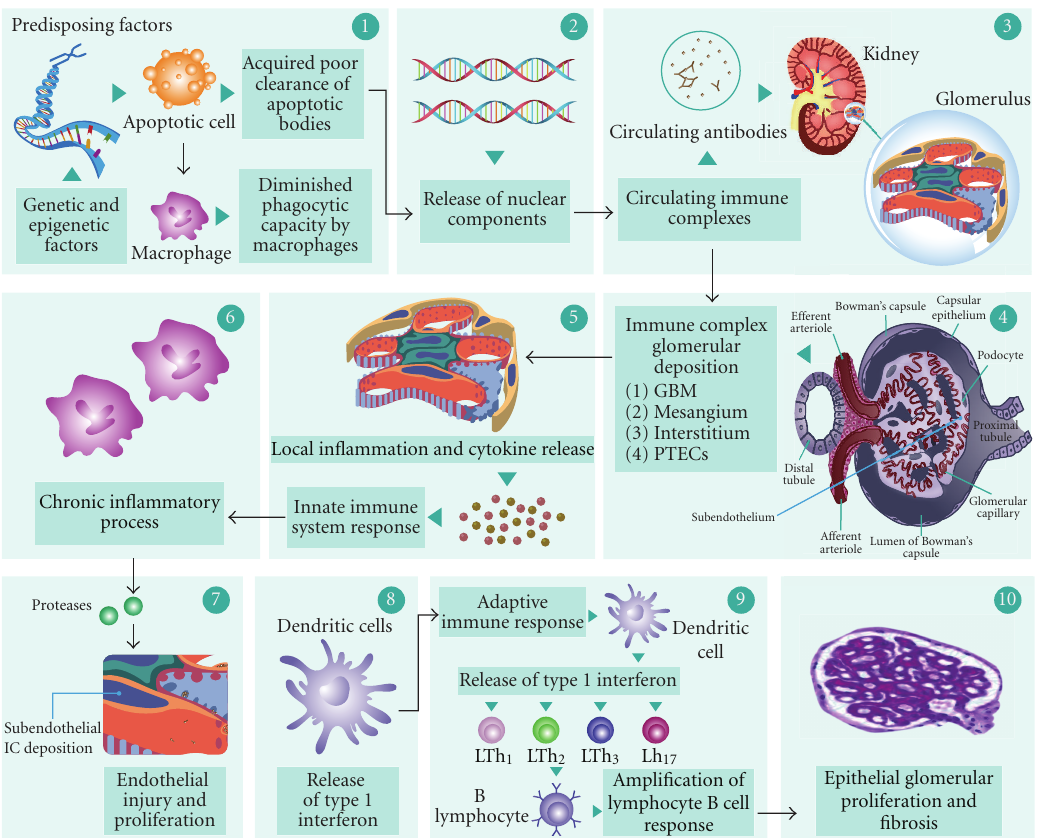
Figure 1: Lupus nephritis: an imbalance between cytokine homeostasis and immune complex deposition. In predisposing susceptible individuals who develop systemic lupus erythematosus (SLE), there is an acquired poor clearance of apoptotic bodies and a diminished phagocytic capacity by macrophages (1). Early formation of immune complexes (ICs) include antinucleosomes, anti-double-stranded DNA (anti-dsDNA), DNA extractable nuclear antigen antibodies (ENAS), antibodies against C1q complex of the complement system, free DNA, antiribonucleoproteins (anti-RNP), and histones as byproducts of ine ffi cient phagocytosis of apoptotic bodies (2). Circulating ICs are deposited initially at the glomerular base membrane (GBM), mesangium, and interstitial tissue within the proximal tubular epithelial cells (PTECs) (3) and (4). The deposited ICs initiate the release of proinflammatory cytokines and chemokines such as monocyte chemoattractant protein 1 (MCP-1), interleukins 1 and 6 (IL-1, IL-6) and adhesion molecules (CAMs) thus establishing a chronic inflammatory process (5). The resulting overload of the mesangial phagocytic system (innate immune system) leads to deposits of subendothelial ICs becoming an easy target for monocyte migration and infiltration and generating endothelial injury and proliferation (6) and (7). In turn, the adaptive immune system is activated secondary to the presence of ICs and dendritic cells (DCs) (8), which subsequently trigger release of type 1 interferon and induce maturation and activation of infiltrating T cells. This activation leads to sequential amplification of T helper 2 lymphocytes (Th2), T helper 1 (Th1), and T helper 17 (Th17) (9). Each of these amplifies lymphocyte B cell response and further activates macrophages, generating a second general response, which increases recruitment of e ff ector cells that can no longer be modulated by regulatory T cells and resulting in the end in epithelial glomerular proliferation and fibrosis